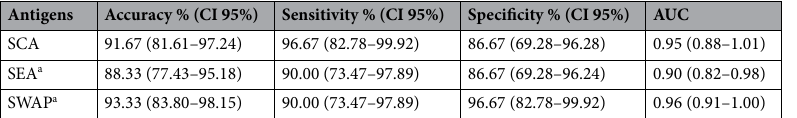
Table 1. Comparison of S. mansoni diagnostic potential of SCA with ELISA diagnostic references. SCA; schistosomula crude antigen, SEA; soluble egg antigen, SWAP; soluble worm antigenic preparation, AUC; area under curve. ( a ) is ELISA diagnostic references—same sera samples used for SCA, SEA and SWAP.